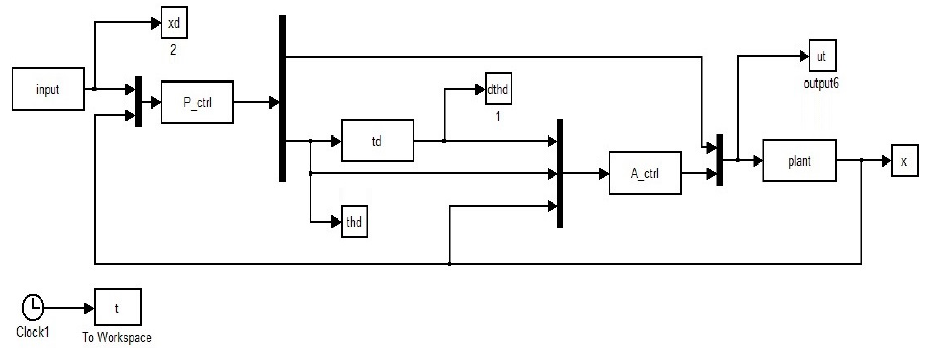
Figure 10. Path Tracking Control Model Based on Sliding Mode Algorithm.